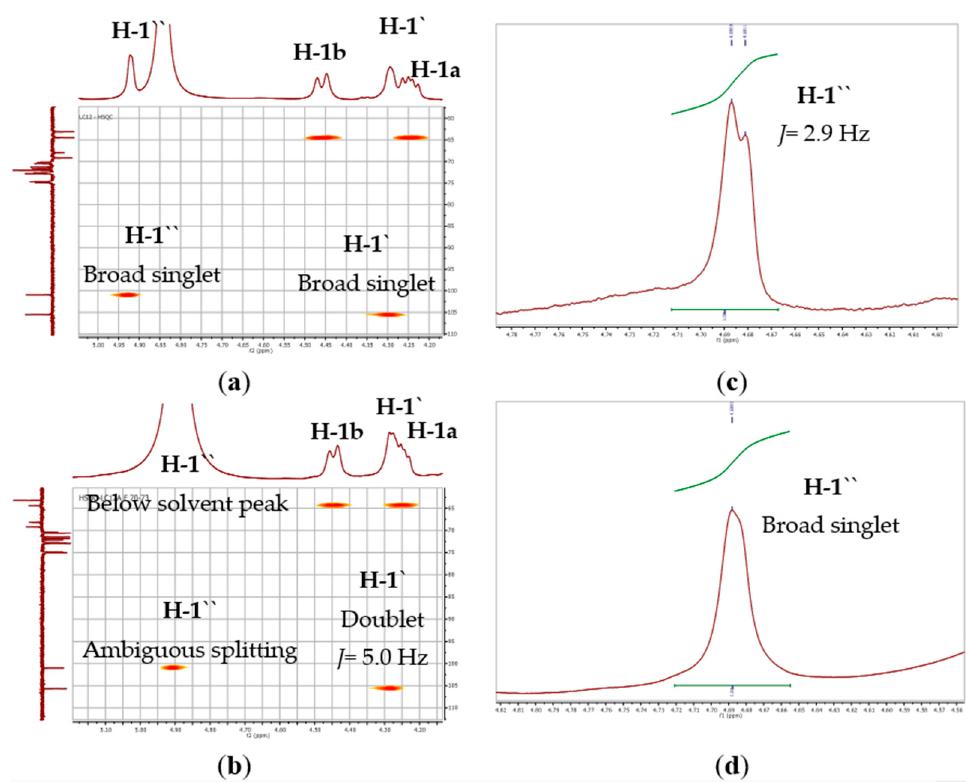
Figure 3. HSQC expansions (4.10–5.10 ppm) of; ( a ) compound 1 and ( b ) compound 2 in CD 3 OD; and 1 H NMR expansions of; ( c ) compound 1 ( δ H 4.60–4.78) and d) compound 2 ( δ H 4.56–4.82) in DMSO- of galactose moieties, H-1 ′ and H-1 ′′ in both solvents.